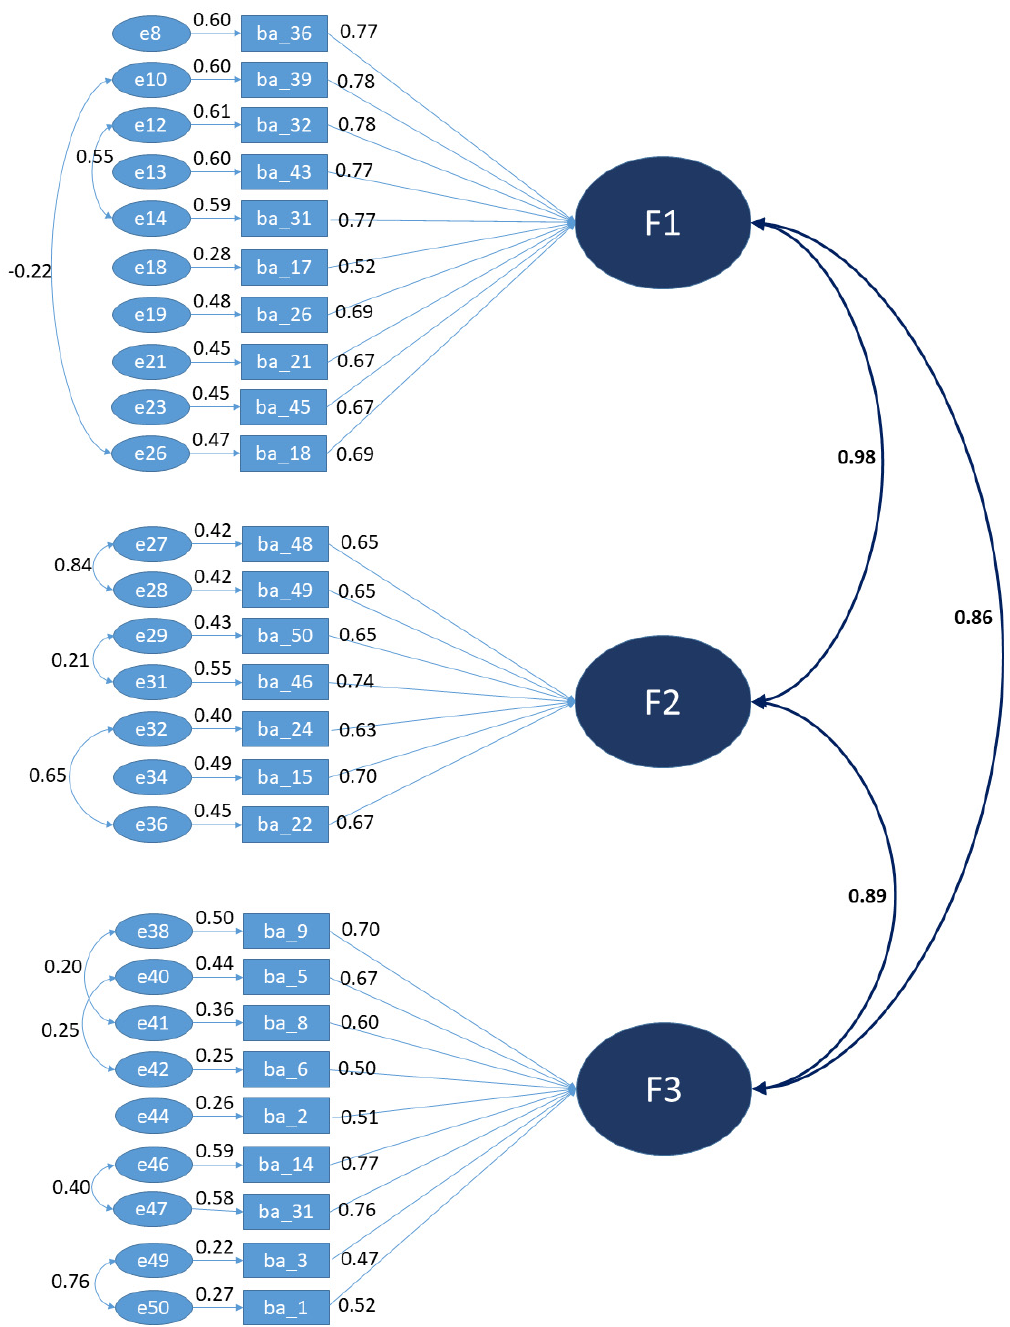
Figure 4. Re − specified model with modified indices by AMOS (A high-resolution version is available in the Supplementary Materials—Figure S2).